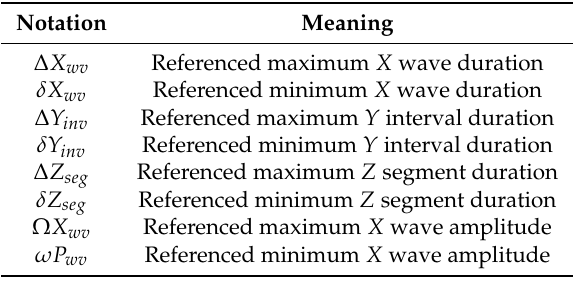
Figure 3. Example of normal and abnormal ECG morphologies. Table 1. Notations for set of referenced normal feature values ( RFV